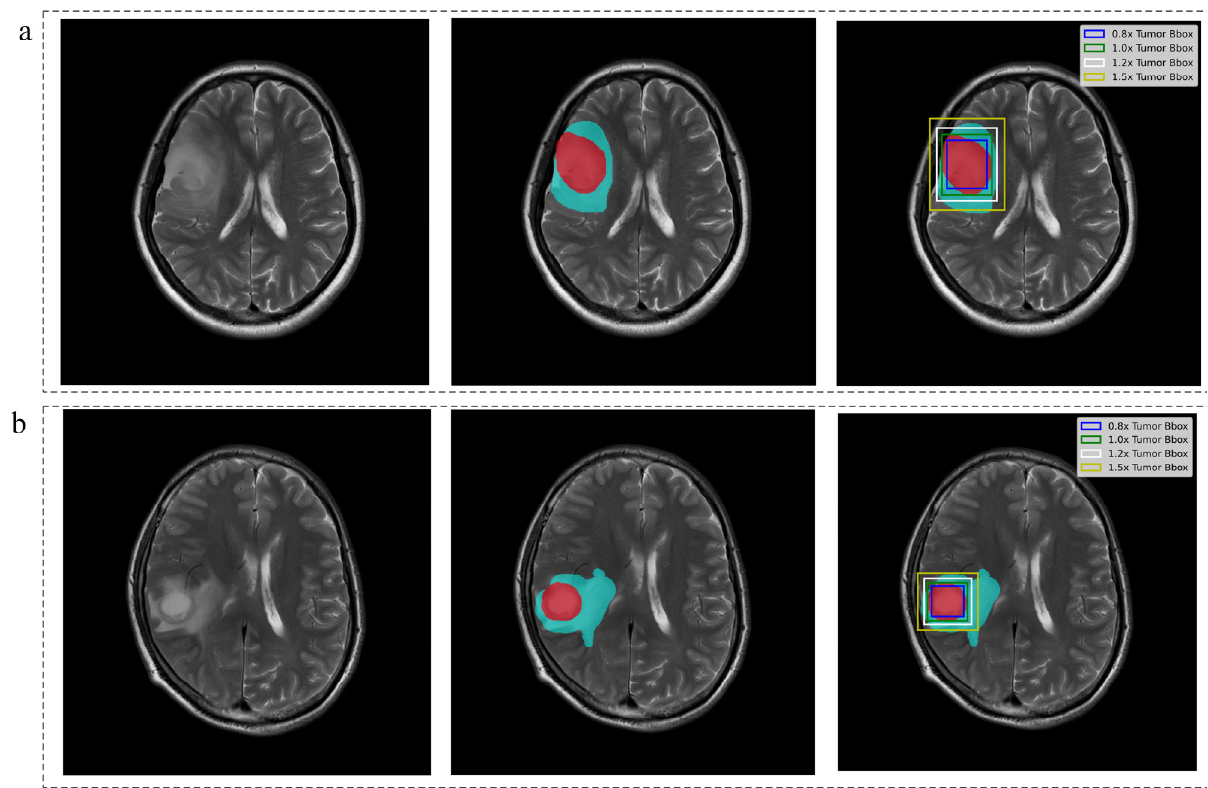
Figure 3. Tumor delineation and image inputs definition. ( a ) IDH-mutant case, female, 59 years old, WHO grade III; ( b ) IDH-wild case, male, 53 years old, WHO grade IV. The two cases enrolled from AHXZ. Red voxels represent tumor and cyan voxels represent edema.